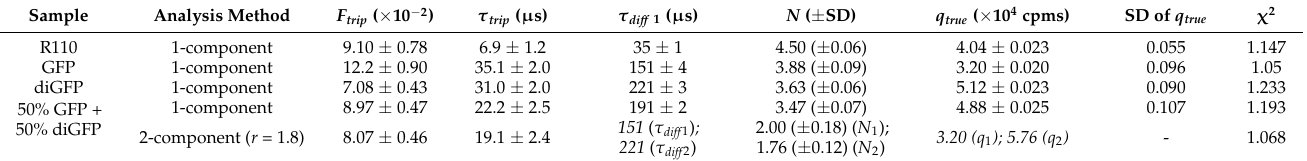
Table 1. Analyses of representative lysate samples from one measurement